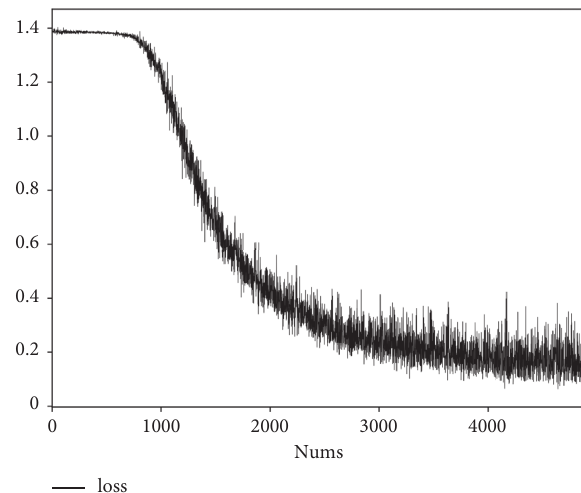
Figure 12: Change of loss rate during LSTM model training.